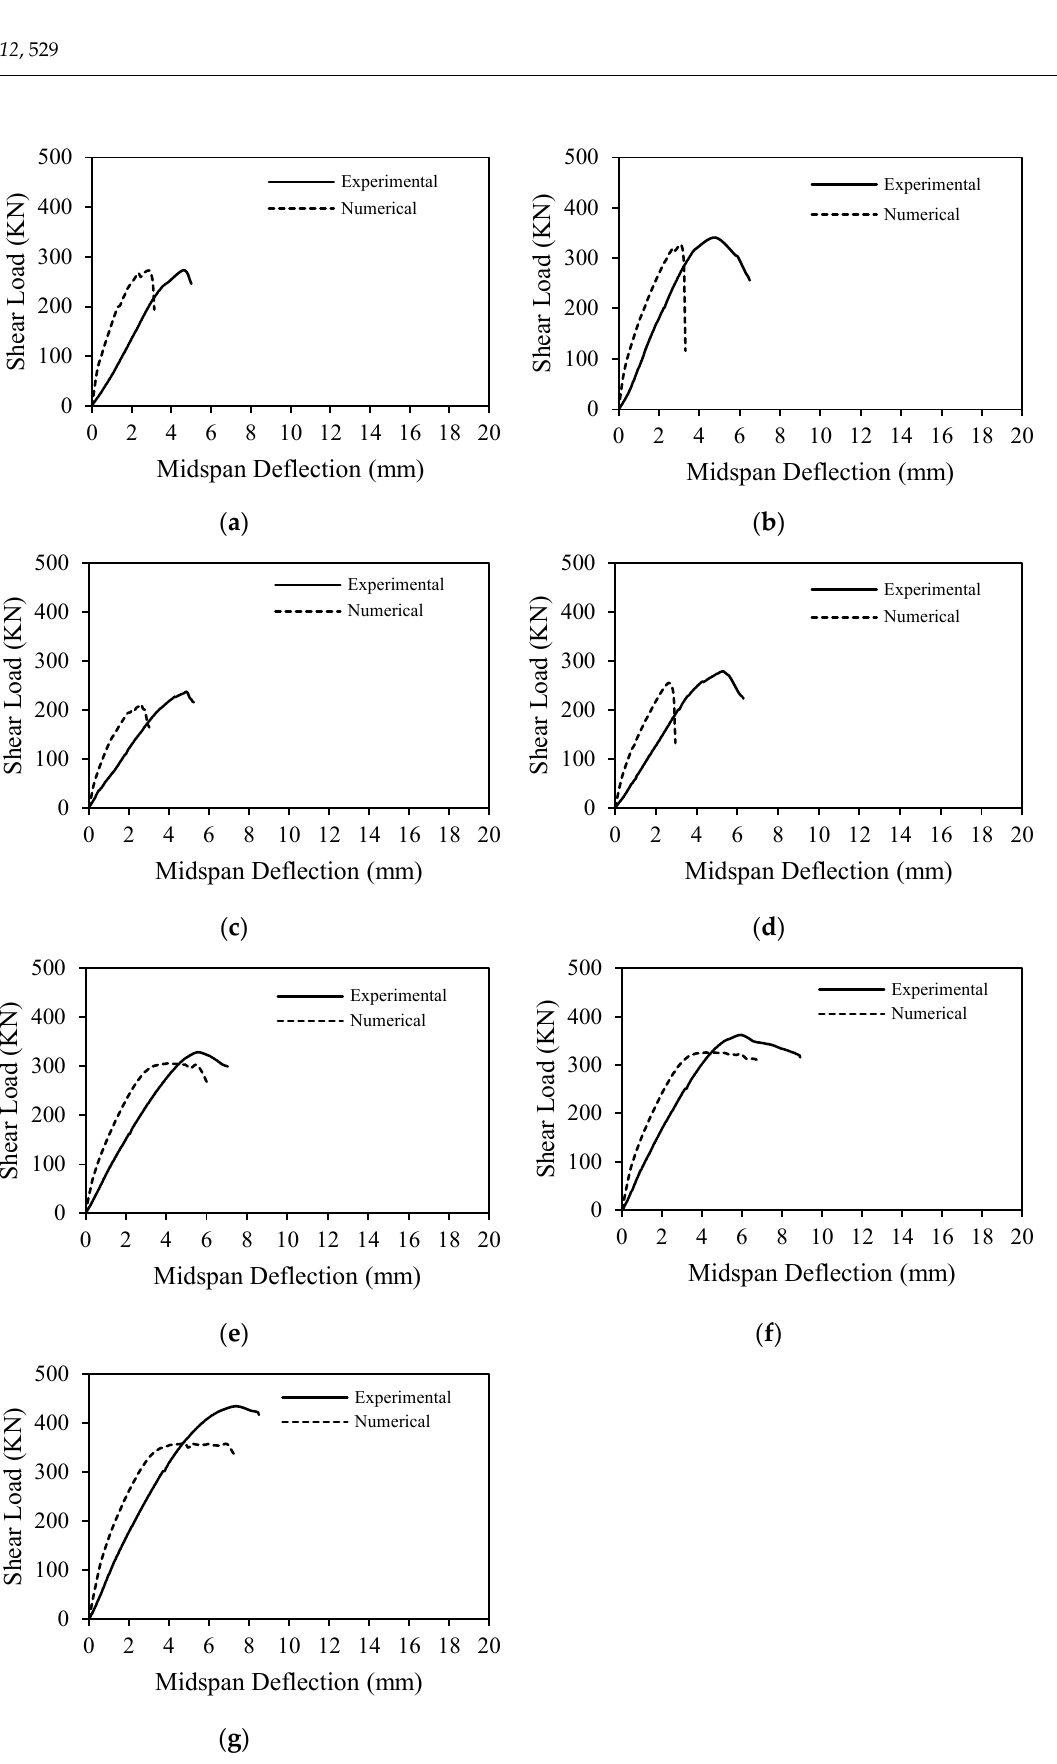
Figure 14. Numerical and experimental responses of group N: ( a ) NR0-SF0; ( b ) NR0-SF0-S; ( c ) NR100-SF0; ( d ) NR100-SF0-S; ( e ) NR100-SF1; ( f ) NR100-SF2; and ( g ) NR100-SF3.